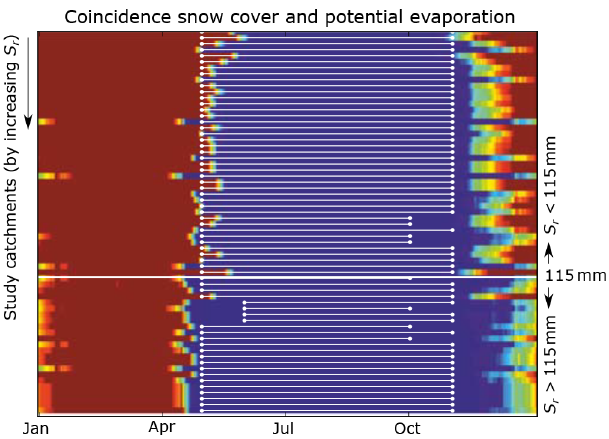
Figure 9. Snow cover is presented by the colour plot (red: S SWE > 15mm, blue: S SWE = 0). Occurrence of potential evaporation ( E p > 0) is presented by white lines; note that the actual amount of E p is not presented. Presented data are long-term daily averages. Catchments are ordered by increasing S r